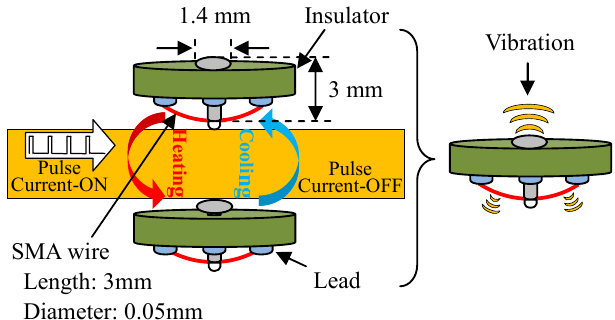
Fig.4 Structure of Vibration Actuator Tip of finger